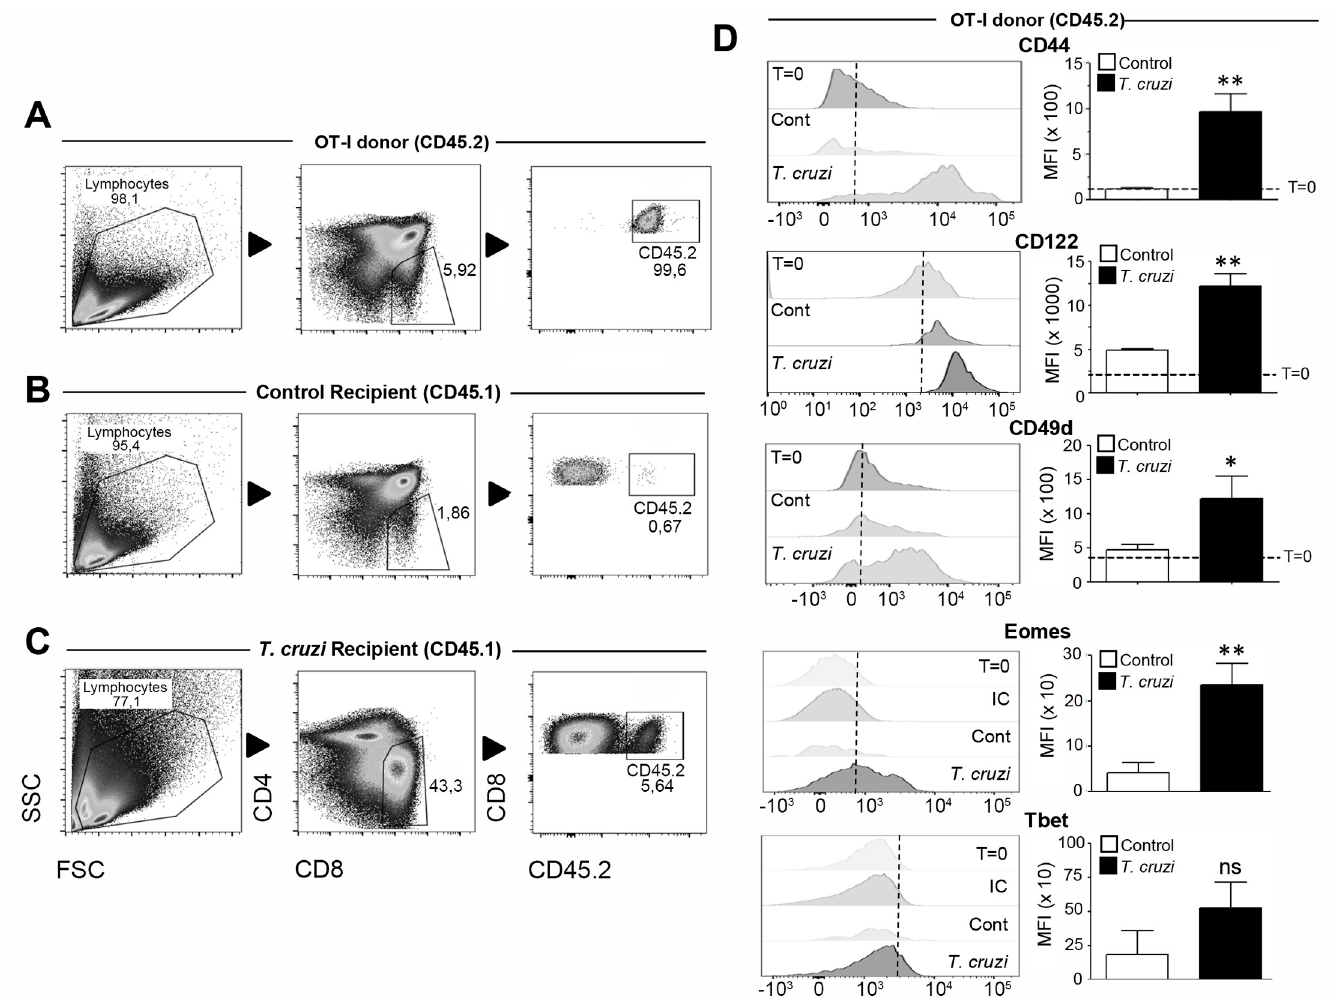
Fig 9. Innate CD8 + cells appearance in the thymus is a SP8 lineage decision. CD45.1 + Control or T . cruzi- infected (Tulahuen) WT mice at day 12 post-infection (recipient mice) were anaesthetized and i.t. injected with 10 x 10 6 CD45.2 + thymocytes from the same control OT-I mouse (donor). After 48h, mice were sacrificed and the thymi were harvested. Dot plot shows the gate strategy for analysis of: (A) CD45.2 + SP8 OT-I thymocytes before being injected and after 48 h of being injected in (B) control or (C) T . cruzi- infected mice. Two days post i.t. injections (D) CD44, CD122, CD49d, Eomes and Tbet expression were analyzed by Flow cytometry in the CD45.2 + SP8 gated OT-I thymocytes. Changes in Eomes and Tbet levels were expressed as the difference between the MFI of Eomes or Tbet and the MFI from the corresponding Isotype control (IC). Histograms are representative of 2 independent experiments with 4–6 mice/group. The statistical test applied was a Student’s unpaired t test, Control vs T-cruzi � p < 0 . 05 and �� p < 0 . 01 .